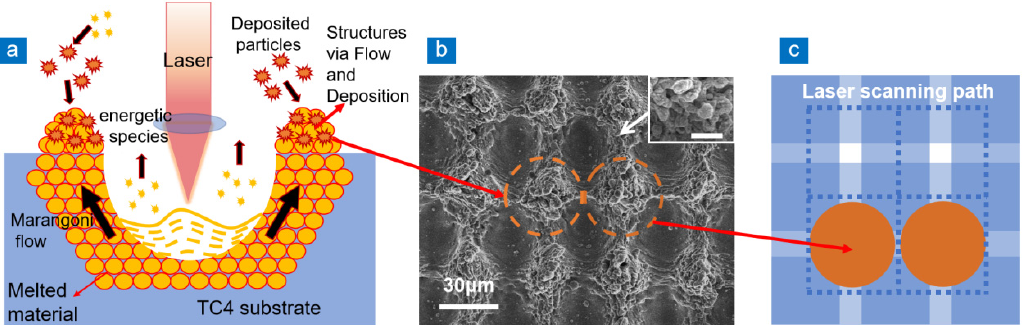
Figure 1. Generation mechanism and SEM diagram of recast layer. ( a ) Generation mechanism of recast layer, ( b ) SEM images of high duty ratio structure of TC4 sample surface (the scale bar in the top-right corner is 1 μ m), ( c ) laser scanning path.